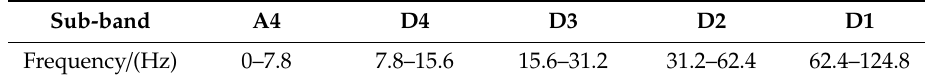
Table 1. Distribution of each sub-band frequency band.